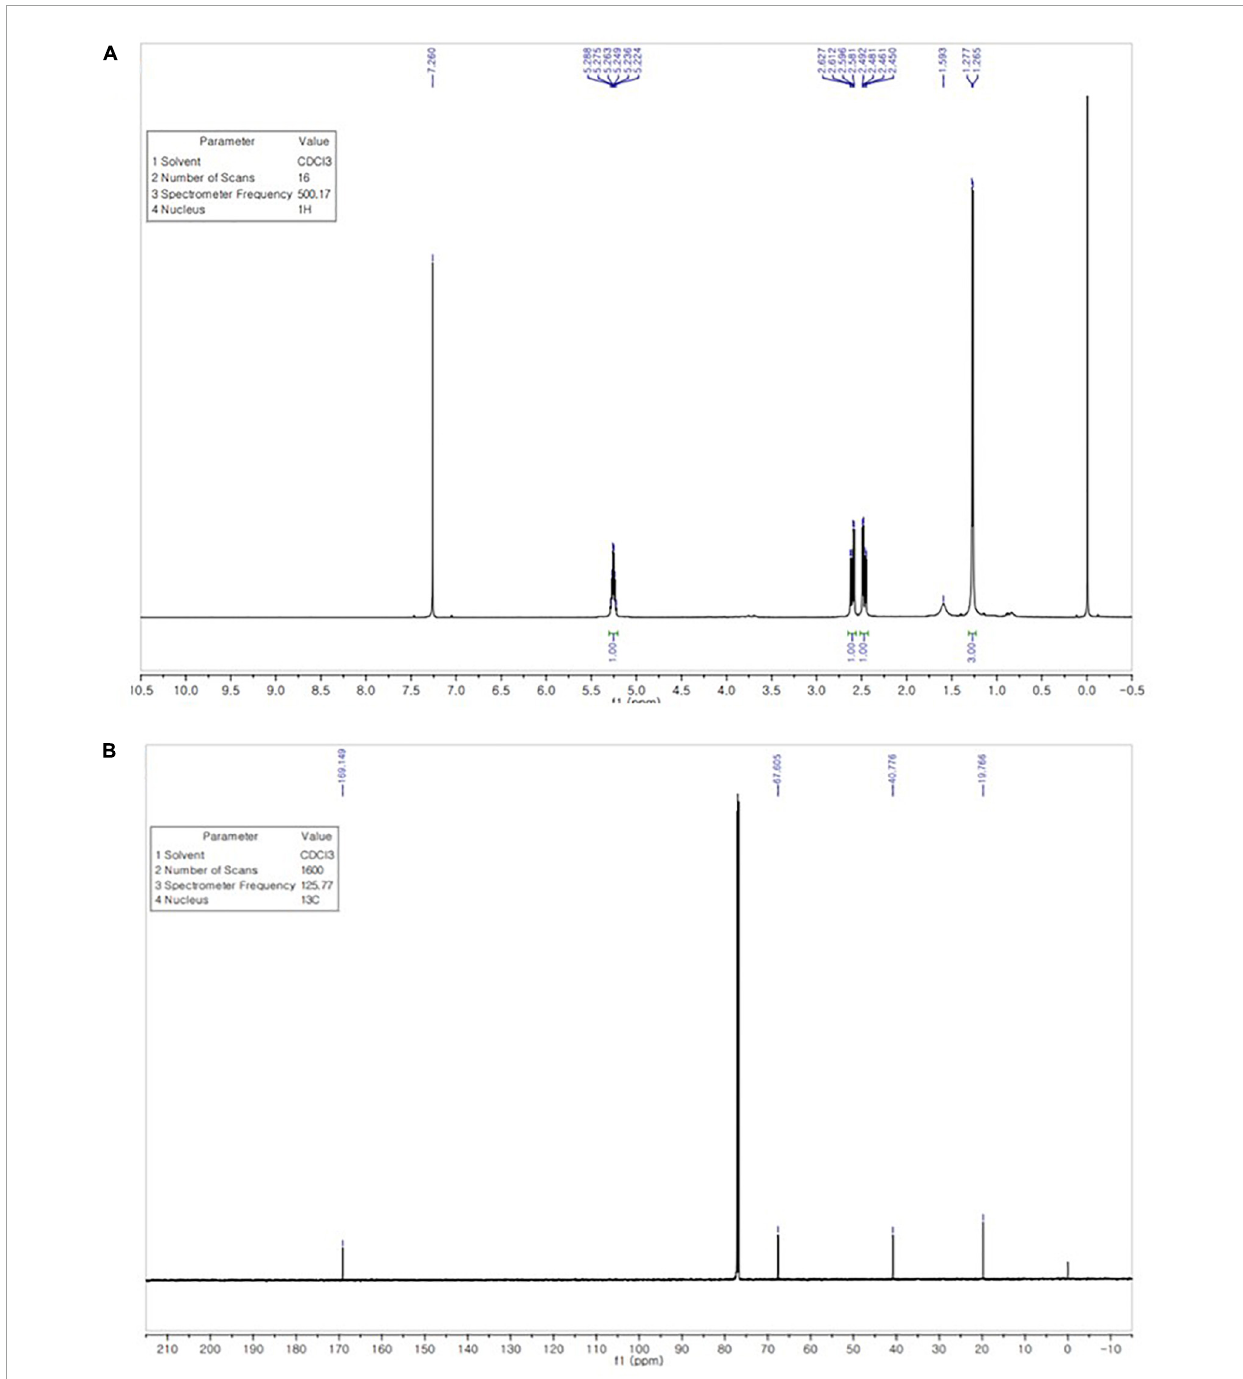
by strain RG36 T when growth is nutrient limited ( Supplementary Figure 1C ). After 48 h of incubation in the presence of glucose as a carbon source at 30 ◦ C, crude extract of PHB was dried at room temperature. Next day the crude extract was turns into white plastic film, which was later quantified by FTIR, NMR, and GC- MS analysis. The weight of plastic film was found to be 0.65 g/L when measured in electronic balance, which is very less